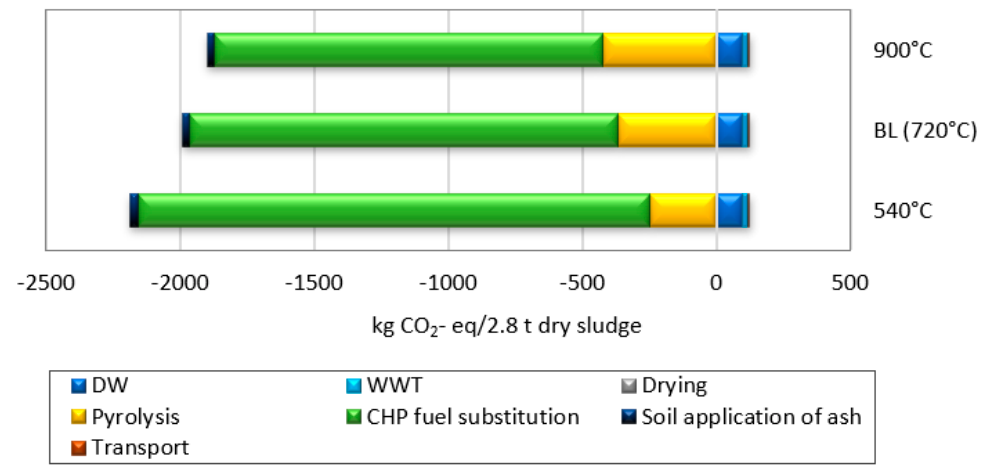
Figure 5. Sensitivity of the GHG emissions abatement of Pyrochar Scenario to the pyrolysis temperature 540 °C, 720 °C (baseline-BL) and 900 °C.